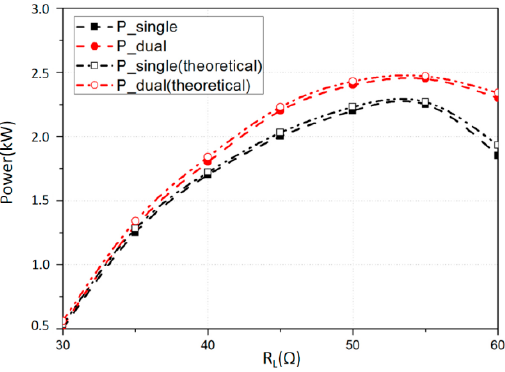
Figure 15. Maximum power transfer curve comparison of the single- and dual-channel systems.